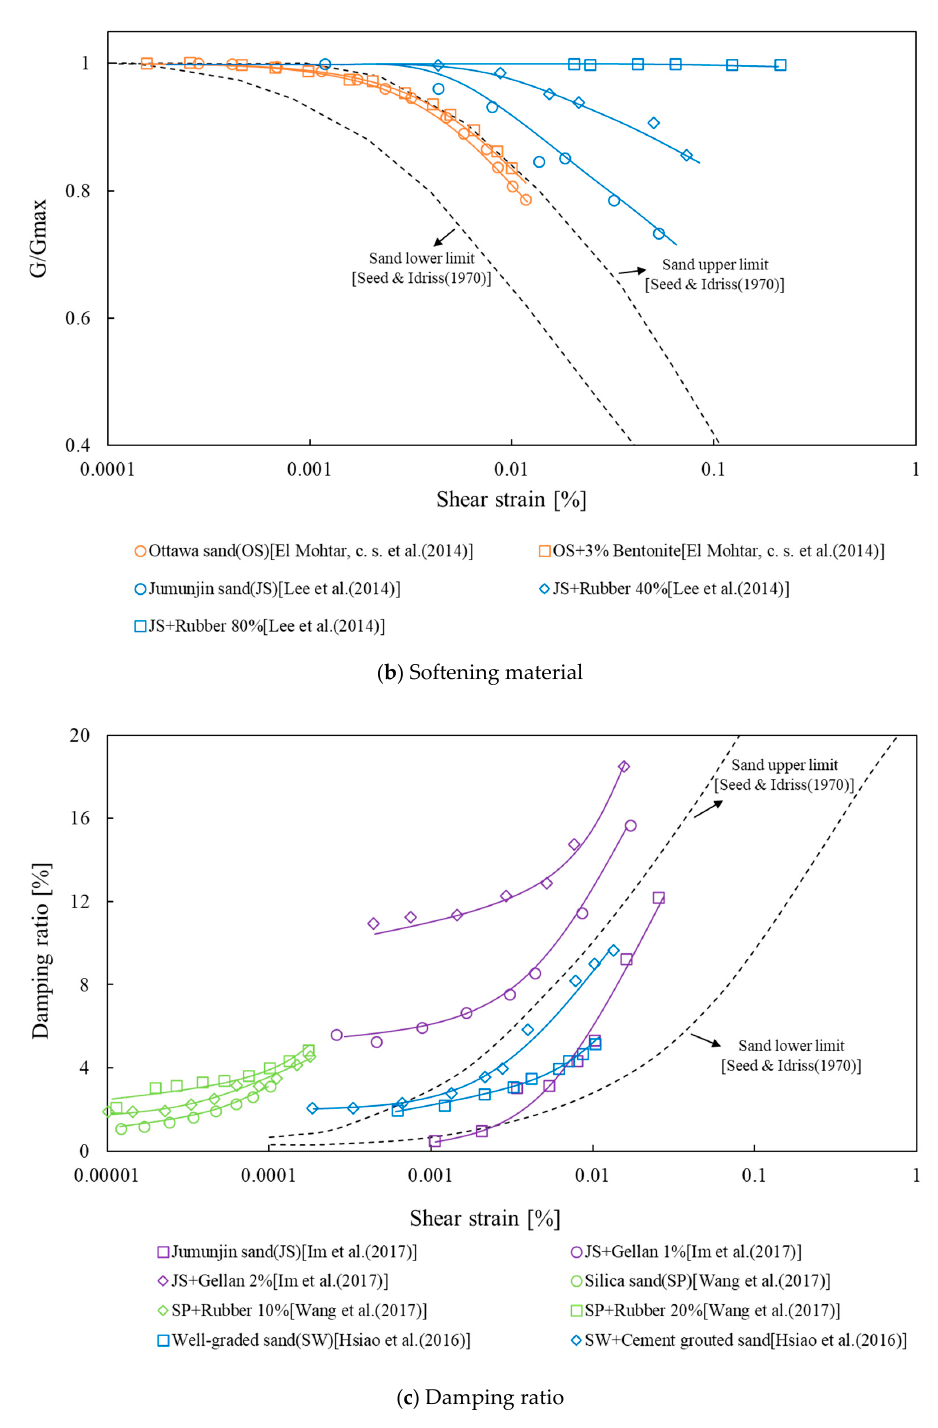
Figure 1. Previous studies of the dynamic characteristics of treated soil: ( a ) Hardening material; ( b ) Softening material; ( c ) Damping ratio. G: shear modulus.